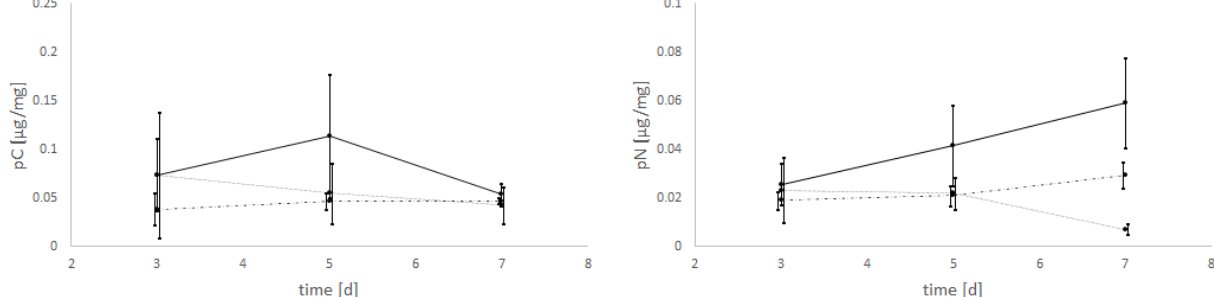
Figure 2. Salinity effects on the uptake of C (pC) and N (pN) from the green algae D. tertiolecta by E. excavatum after different feeding times at 20 ◦ C and a light–dark cycle of 18 : 6h.